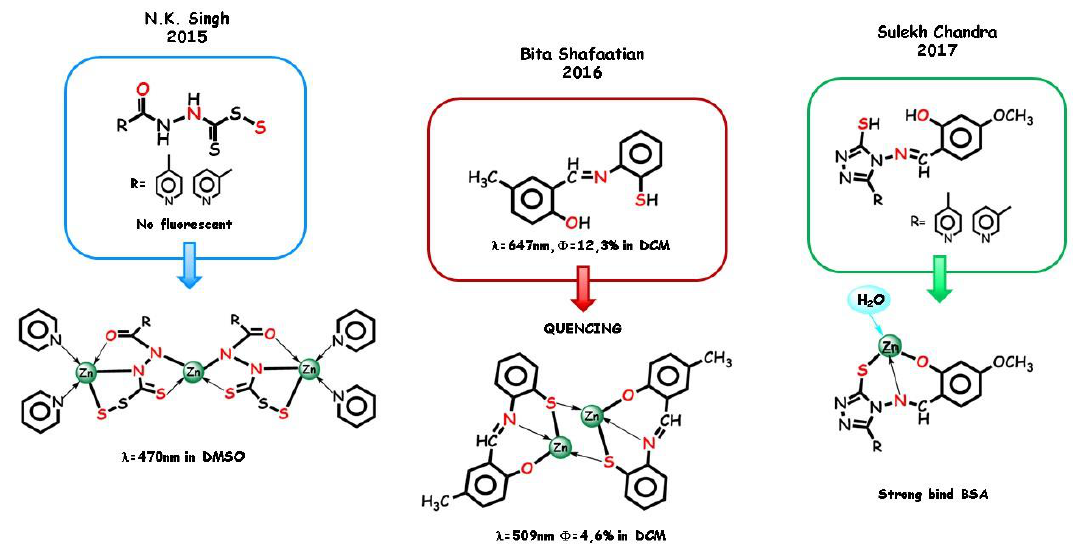
Figure 12. Selected example of N , S , O tridentate pincers and their complexes.